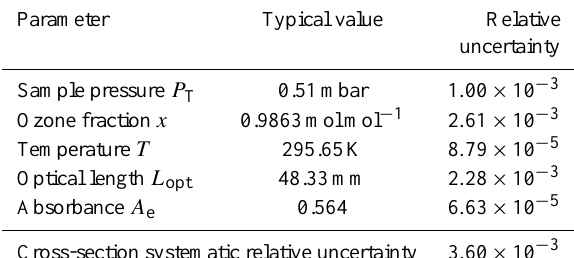
Table 2. Uncertainty budget for the ozone absorption cross-section measurement, indicated here for one typical measurement of the ozone absorption cross-section at a sample pressure of 0.51mbar and a laser wavelength of 244.06nm.